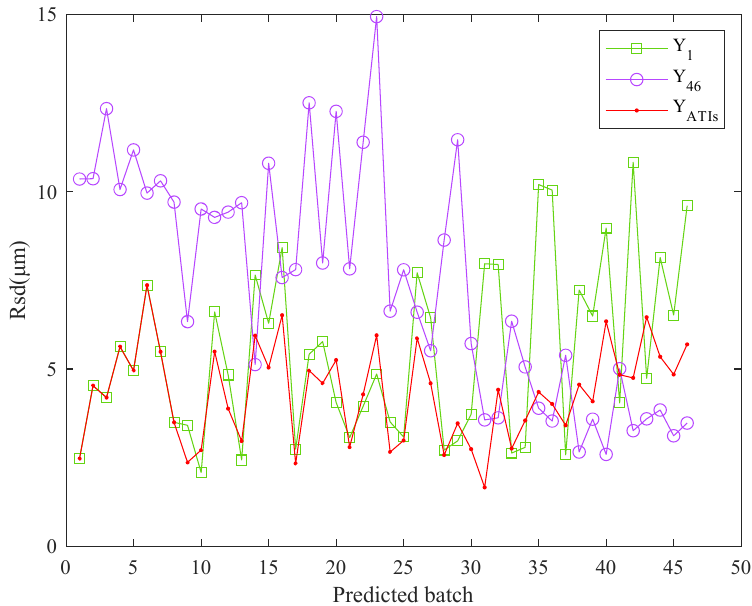
Figure 10. Prediction results of the three models for the annual experiments.